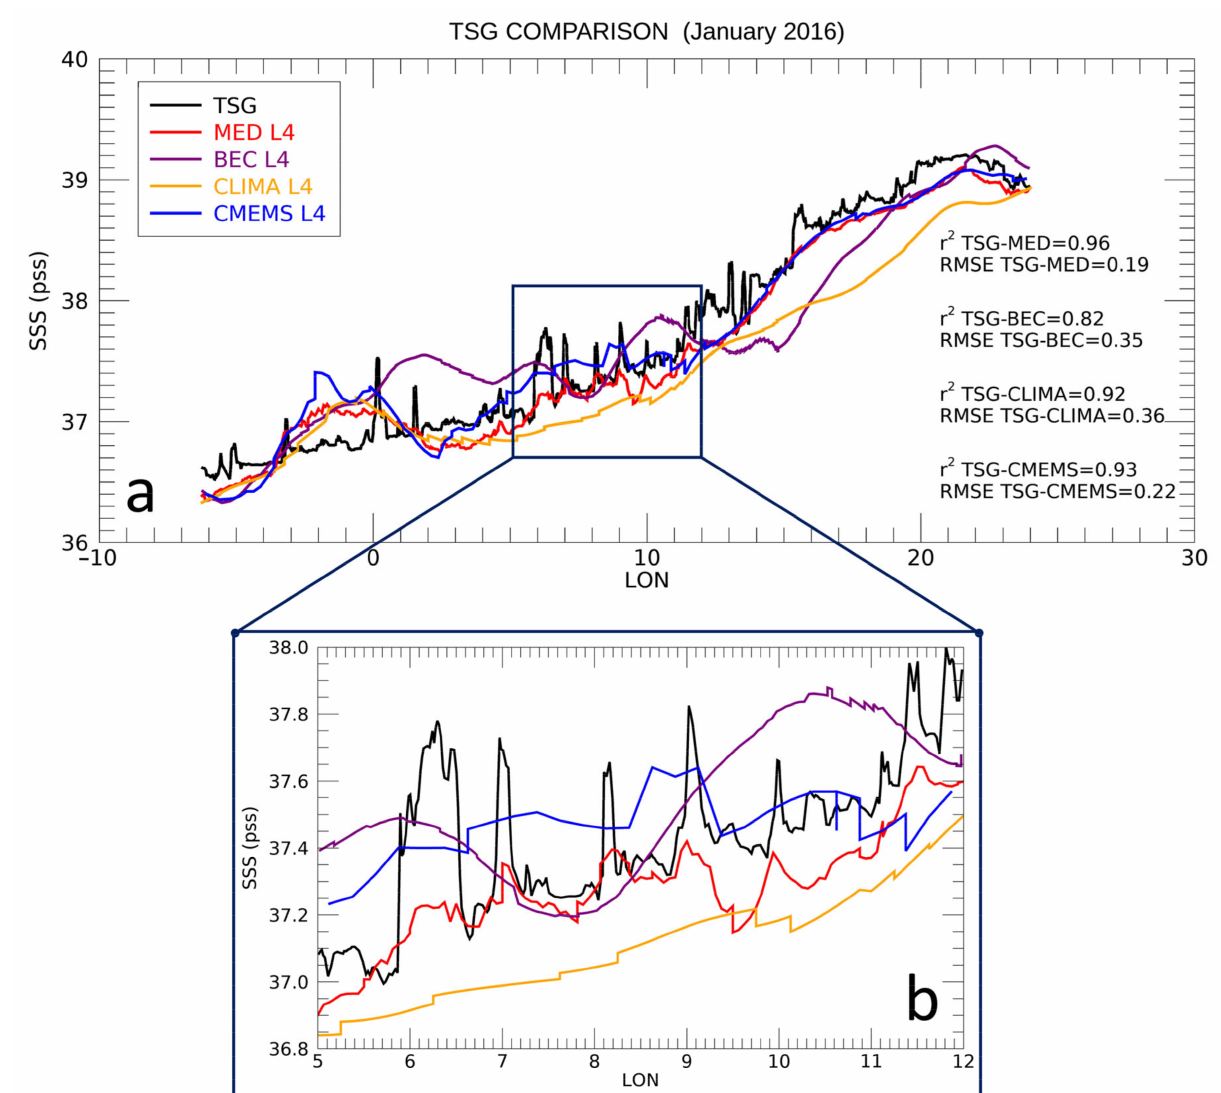
Figure 8. ( a ) Comparison between TSG observations (black line), Med L4 SSS (in red), BEC L4 SSS (in purple), in situ monthly climatology L4 SSS (in yellow), and CMEMS L4 SSS (in blue). ( b ) Zoom of TSG and L4 products’ comparison between 5–12 ◦ E. The TSG trajectory refers to trans-Mediterranean track samples, between 22–31 January